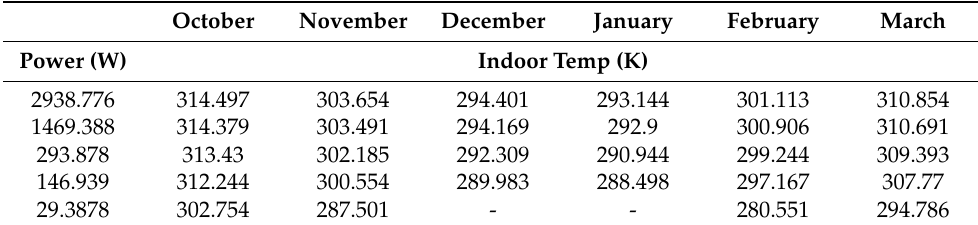
Table 3. From October to February, the indoor air temperature according to the fan power of the heater.